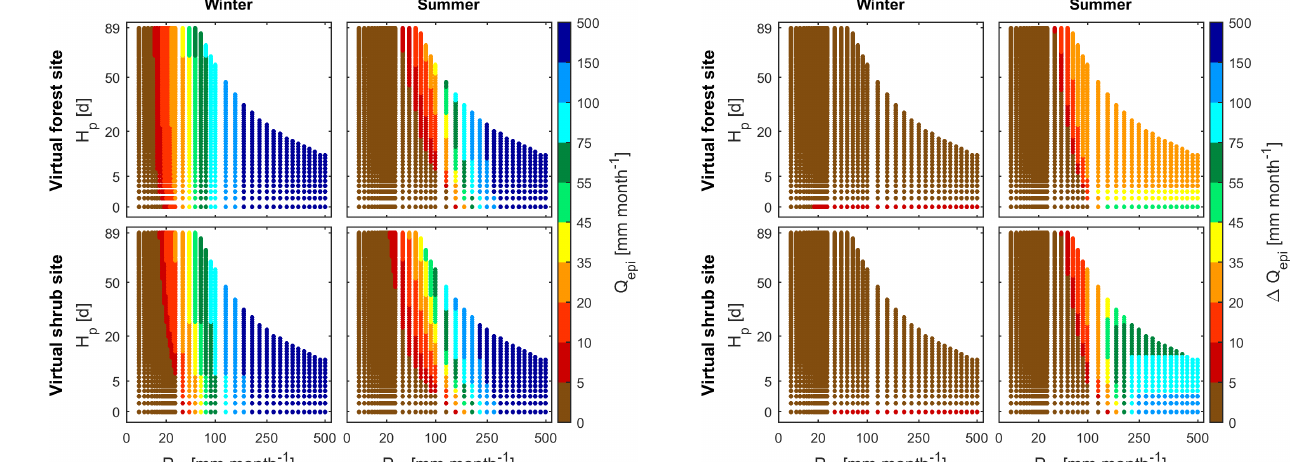
Figure 9. Change in monthly recharge ( (cid:49)Q epi = Q shrub simulated with V2Karst when the land cover is set to shrub com- pared to forest for different values of average monthly precipitation P m (mmmonth − 1 ) and the interval between wet days H p (days) of the synthetic periodic precipitation input used to force the model, at the virtual forest and shrub sites and under winter and summer